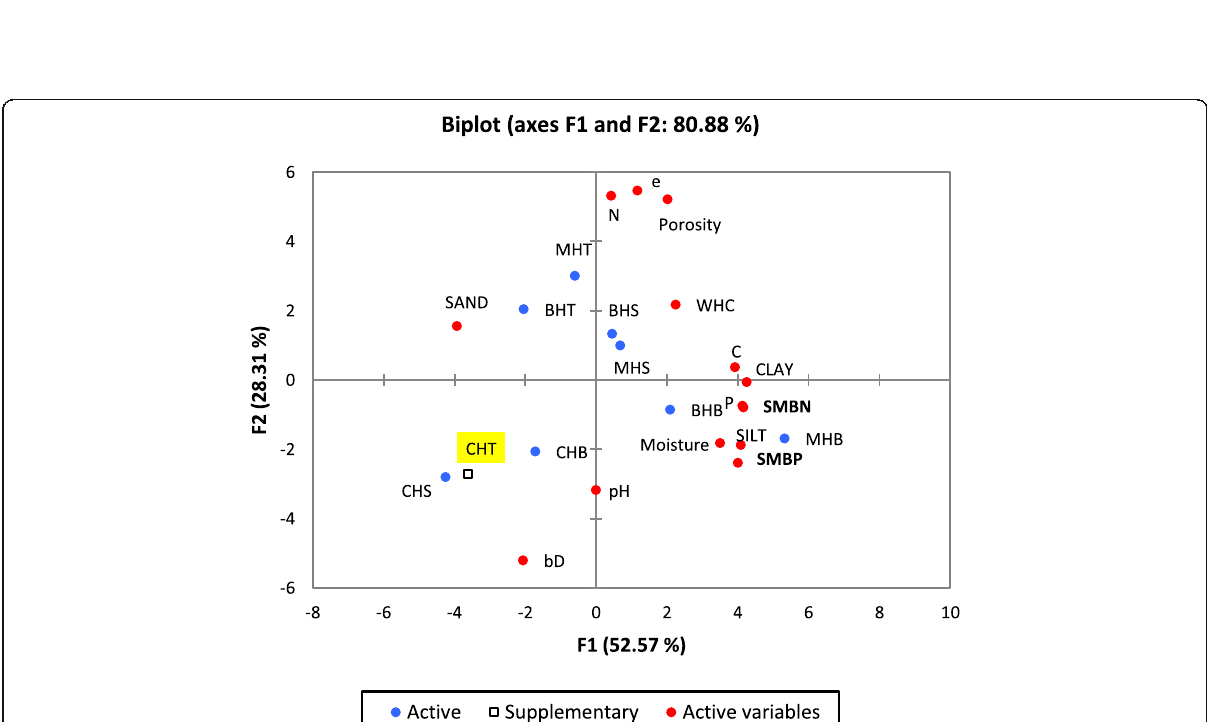
Fig. 3 Principal component analysis (PCA) of soil physical, chemical, and microbial properties in three forest types. PCA axis 1 expressed 52.57% and axis 2 represented 28.31% for first and second coordinates of sites, respectively. bD, bulk density; WHC, water holding capacity; e, void ratio; C, carbon; N, nitrogen; P, phosphorus; SMBN, soil microbial biomass nitrogen; SMBP, soil microbial biomass phosphorus; BHB, Banj oak hill base; BHS, Banj oak hill slope; BHT, Banj oak hill top; CHB, Chir pine hill base; CHS, Chir pine hill slope; CHT, Chir-pine hill top; MHB, mixed oak-pine hill base; MHS, mixed oak-pine hill slope; MHT, mixed oak-pine hill top